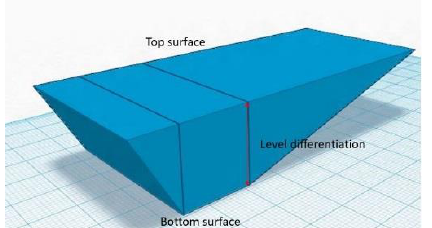
Fig. 6. The truncated pyramid assumption for the water